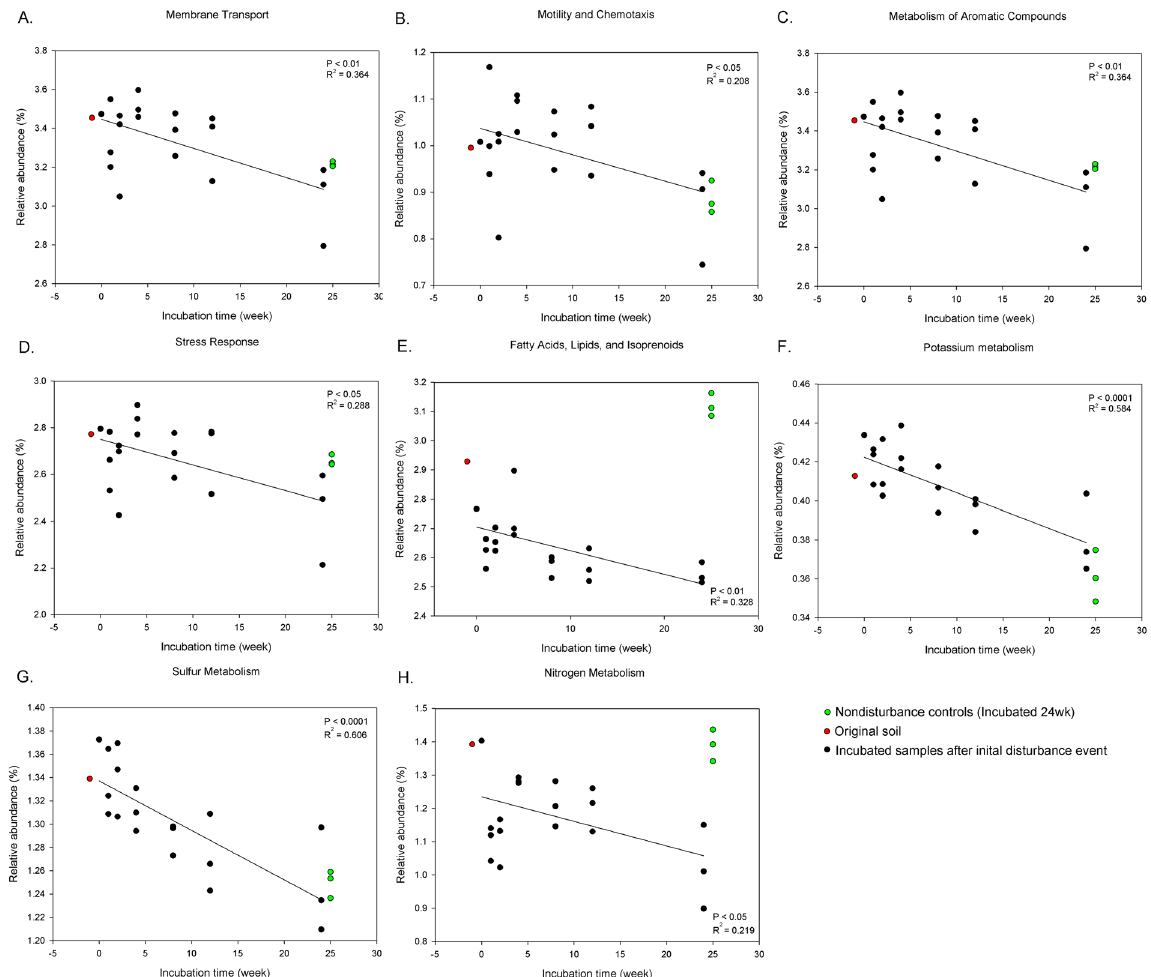
Figure 5. Relationship between incubation time and relative abundance of functional gene categories at subsystem level 1 (SEED database). ( A ) Membrane transport, ( B ) Motility and Chemotaxis, ( C ) Metabolism of Aromatic Compounds, ( D ) Stress Response, ( E ) Fatty Acids, Lipids and Isoprenoids, ( F ) Potassium metabolism, ( G ) Sulfur Metabolism, ( H ) Nitrogen Metabolism. Colored points were not included in the